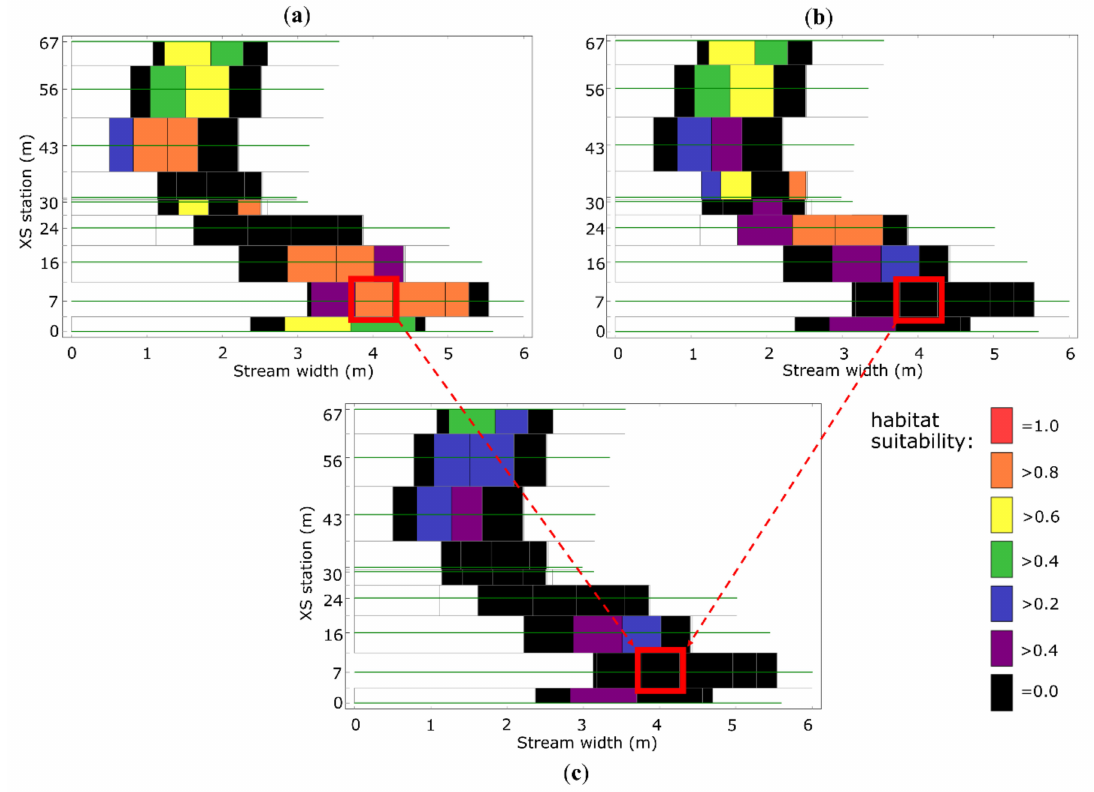
Figure 3. Suitability of the brown trout (BT) in the Teplica River for ( a ) water depth, ( b ) flow velocity, and ( c ) as a combined suitability. The red squares mark the suitability for selected cells and show how the combined weighted usable area (WUA) is calculated. The XS station is the upstream distance of the